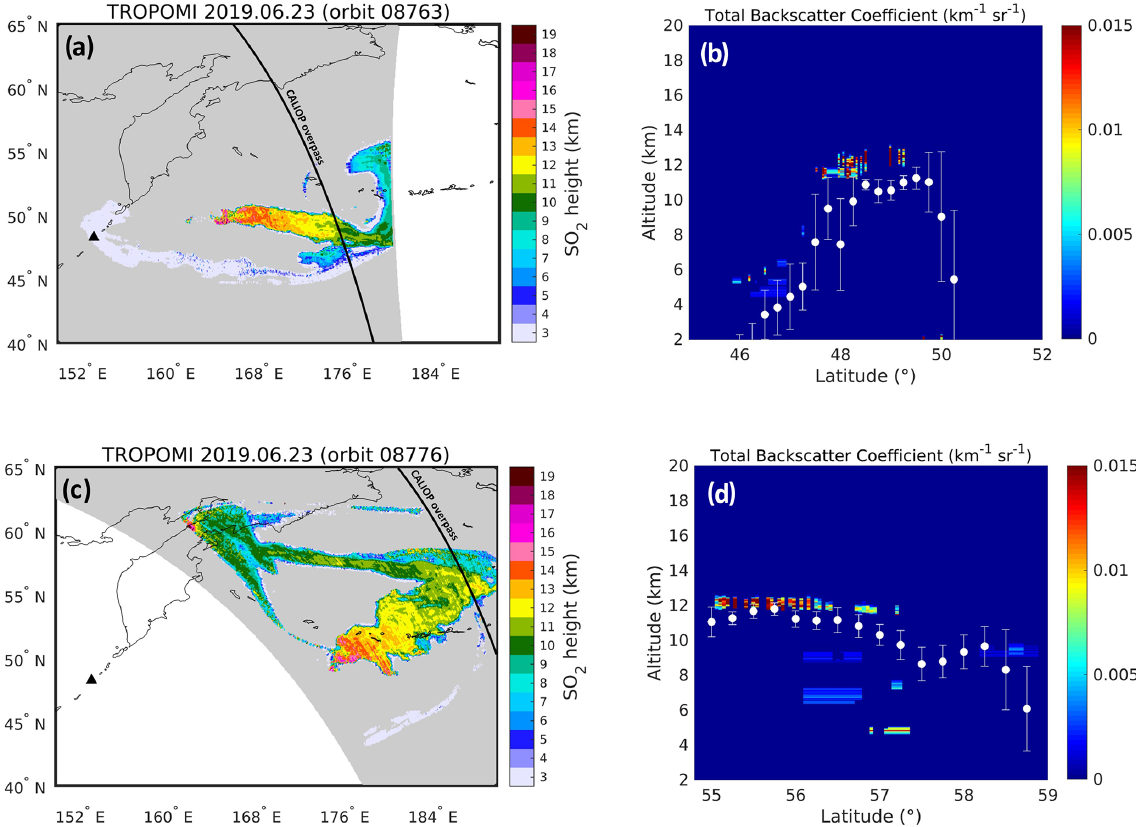
Figure 4. SO 2 layer height results from TROPOMI observations of the Raikoke plume on 23 June 2019, for orbits (a) 08763 and (c) 08776. The retrieved maximum SO 2 VCD is 613 and 274DU, respectively. The Raikoke volcano is marked by a black triangle. The gray pixels indicate the measurements with no SO 2 height retrieval. The black lines indicate the CALIOP overpasses within 1h. (b, d) Comparison between CALIOP plume detection from measured 532 nm total backscatter coefficient and TROPOMI SO 2 LH results, for (a, c) , respectively. The TROPOMI values (in white) are the mean and standard deviation of the SO 2 LH results within 0.25 ◦ × 0.25 ◦ boxes, coincident with